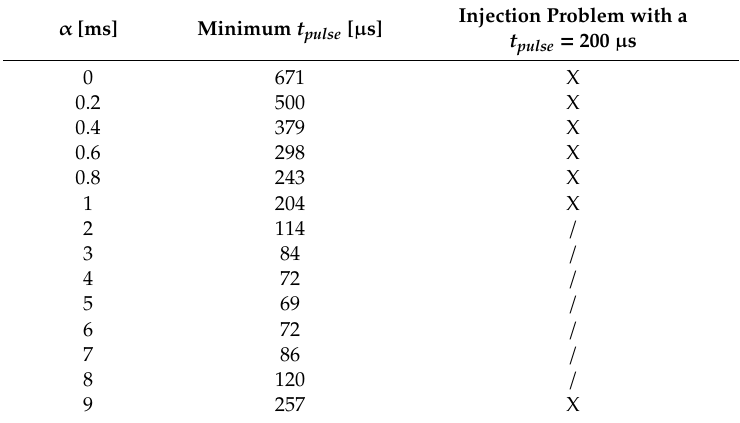
Table 2. Value of the minimum time impulse to get the leaching current for R = 10 Ω and L = 55 mH ( ϕ = 3.3 ms).